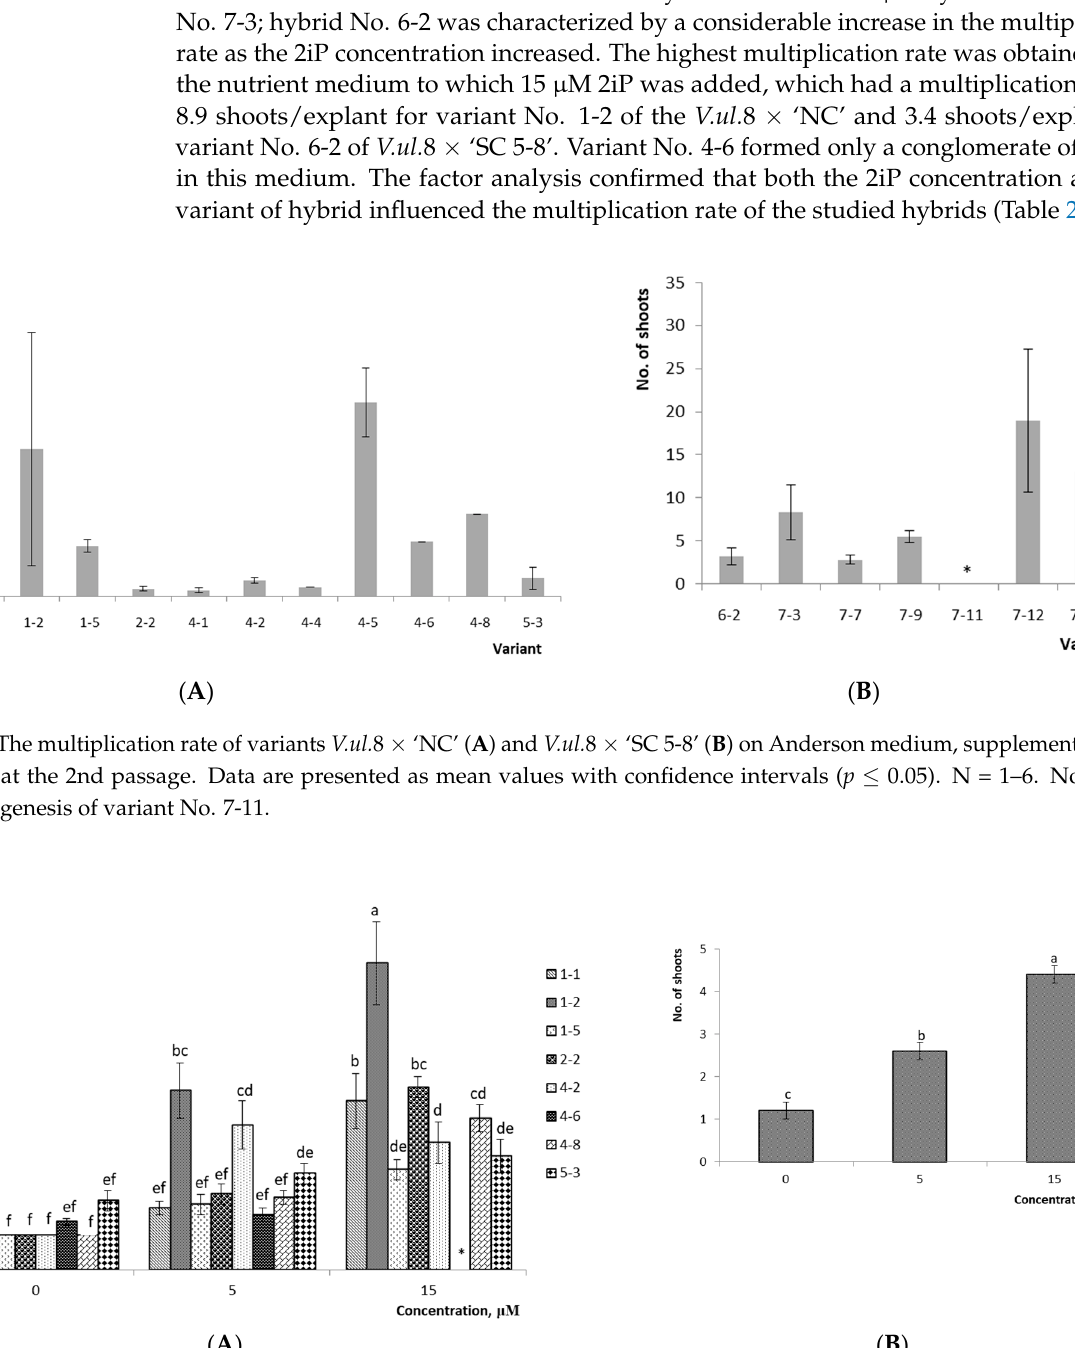
( B ) Figure 5. Effect of 2iP concentration on the multiplication rate of V.ul. 8 x ‘SC 5-8’: ( A ) detailed analysis of values of hybrid variants; ( B ) average values of hybrid variants. Means followed by the same letter are not significantly different according to the LSD at p ≤ 0.05. Note: 6-2, 7-3, 7-9—variant Nos. 6-2, 7-3, 7-9. The mean shoot height of the studied hybrids significantly decreased as the 2iP concentration increased in the nutrient medium (Figures 6 and 7, p ≤ 0.05). Variant Nos. 4-2, 4-8, and 5-3 of the V.ul. 8 × ‘NC’ hybrids had no notable differences between the ex- perimental and the control groups. In the nutrient medium lacking growth regulators, variant Nos. 1-1, 1-2, 1-5, and 2-2 had the highest shoot heights of 72.4, 72.2, 73.4, and 71.4 mm, respectively. A detailed analysis of the shoot height parameter in hybrid variants showed that all variants of the hybrid of V.ul. 8 × ‘SC 5-8’ had significant differences in only the media with 15 μ M 2iP. The highest height was observed for variant No. 6-2 when using nutrition without growth regulators, reaching 43.7 mm. The factor analysis confirmed that the shoot height of the studied hybrids was influenced by both 2iP con- centration and variants of hybrids ( p ≤ 0.05). It should be noted that the combination of factors (concentration × variant) did not significantly affect the height of shoots of V.ul. 8 × ‘SC 5-8’ at p ≤ 0.05 (Table 2).